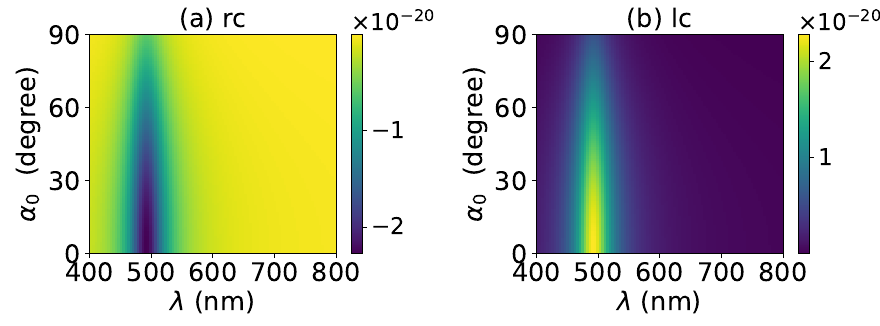
Figure 21. The same as in Figure 20, but with N = 1.